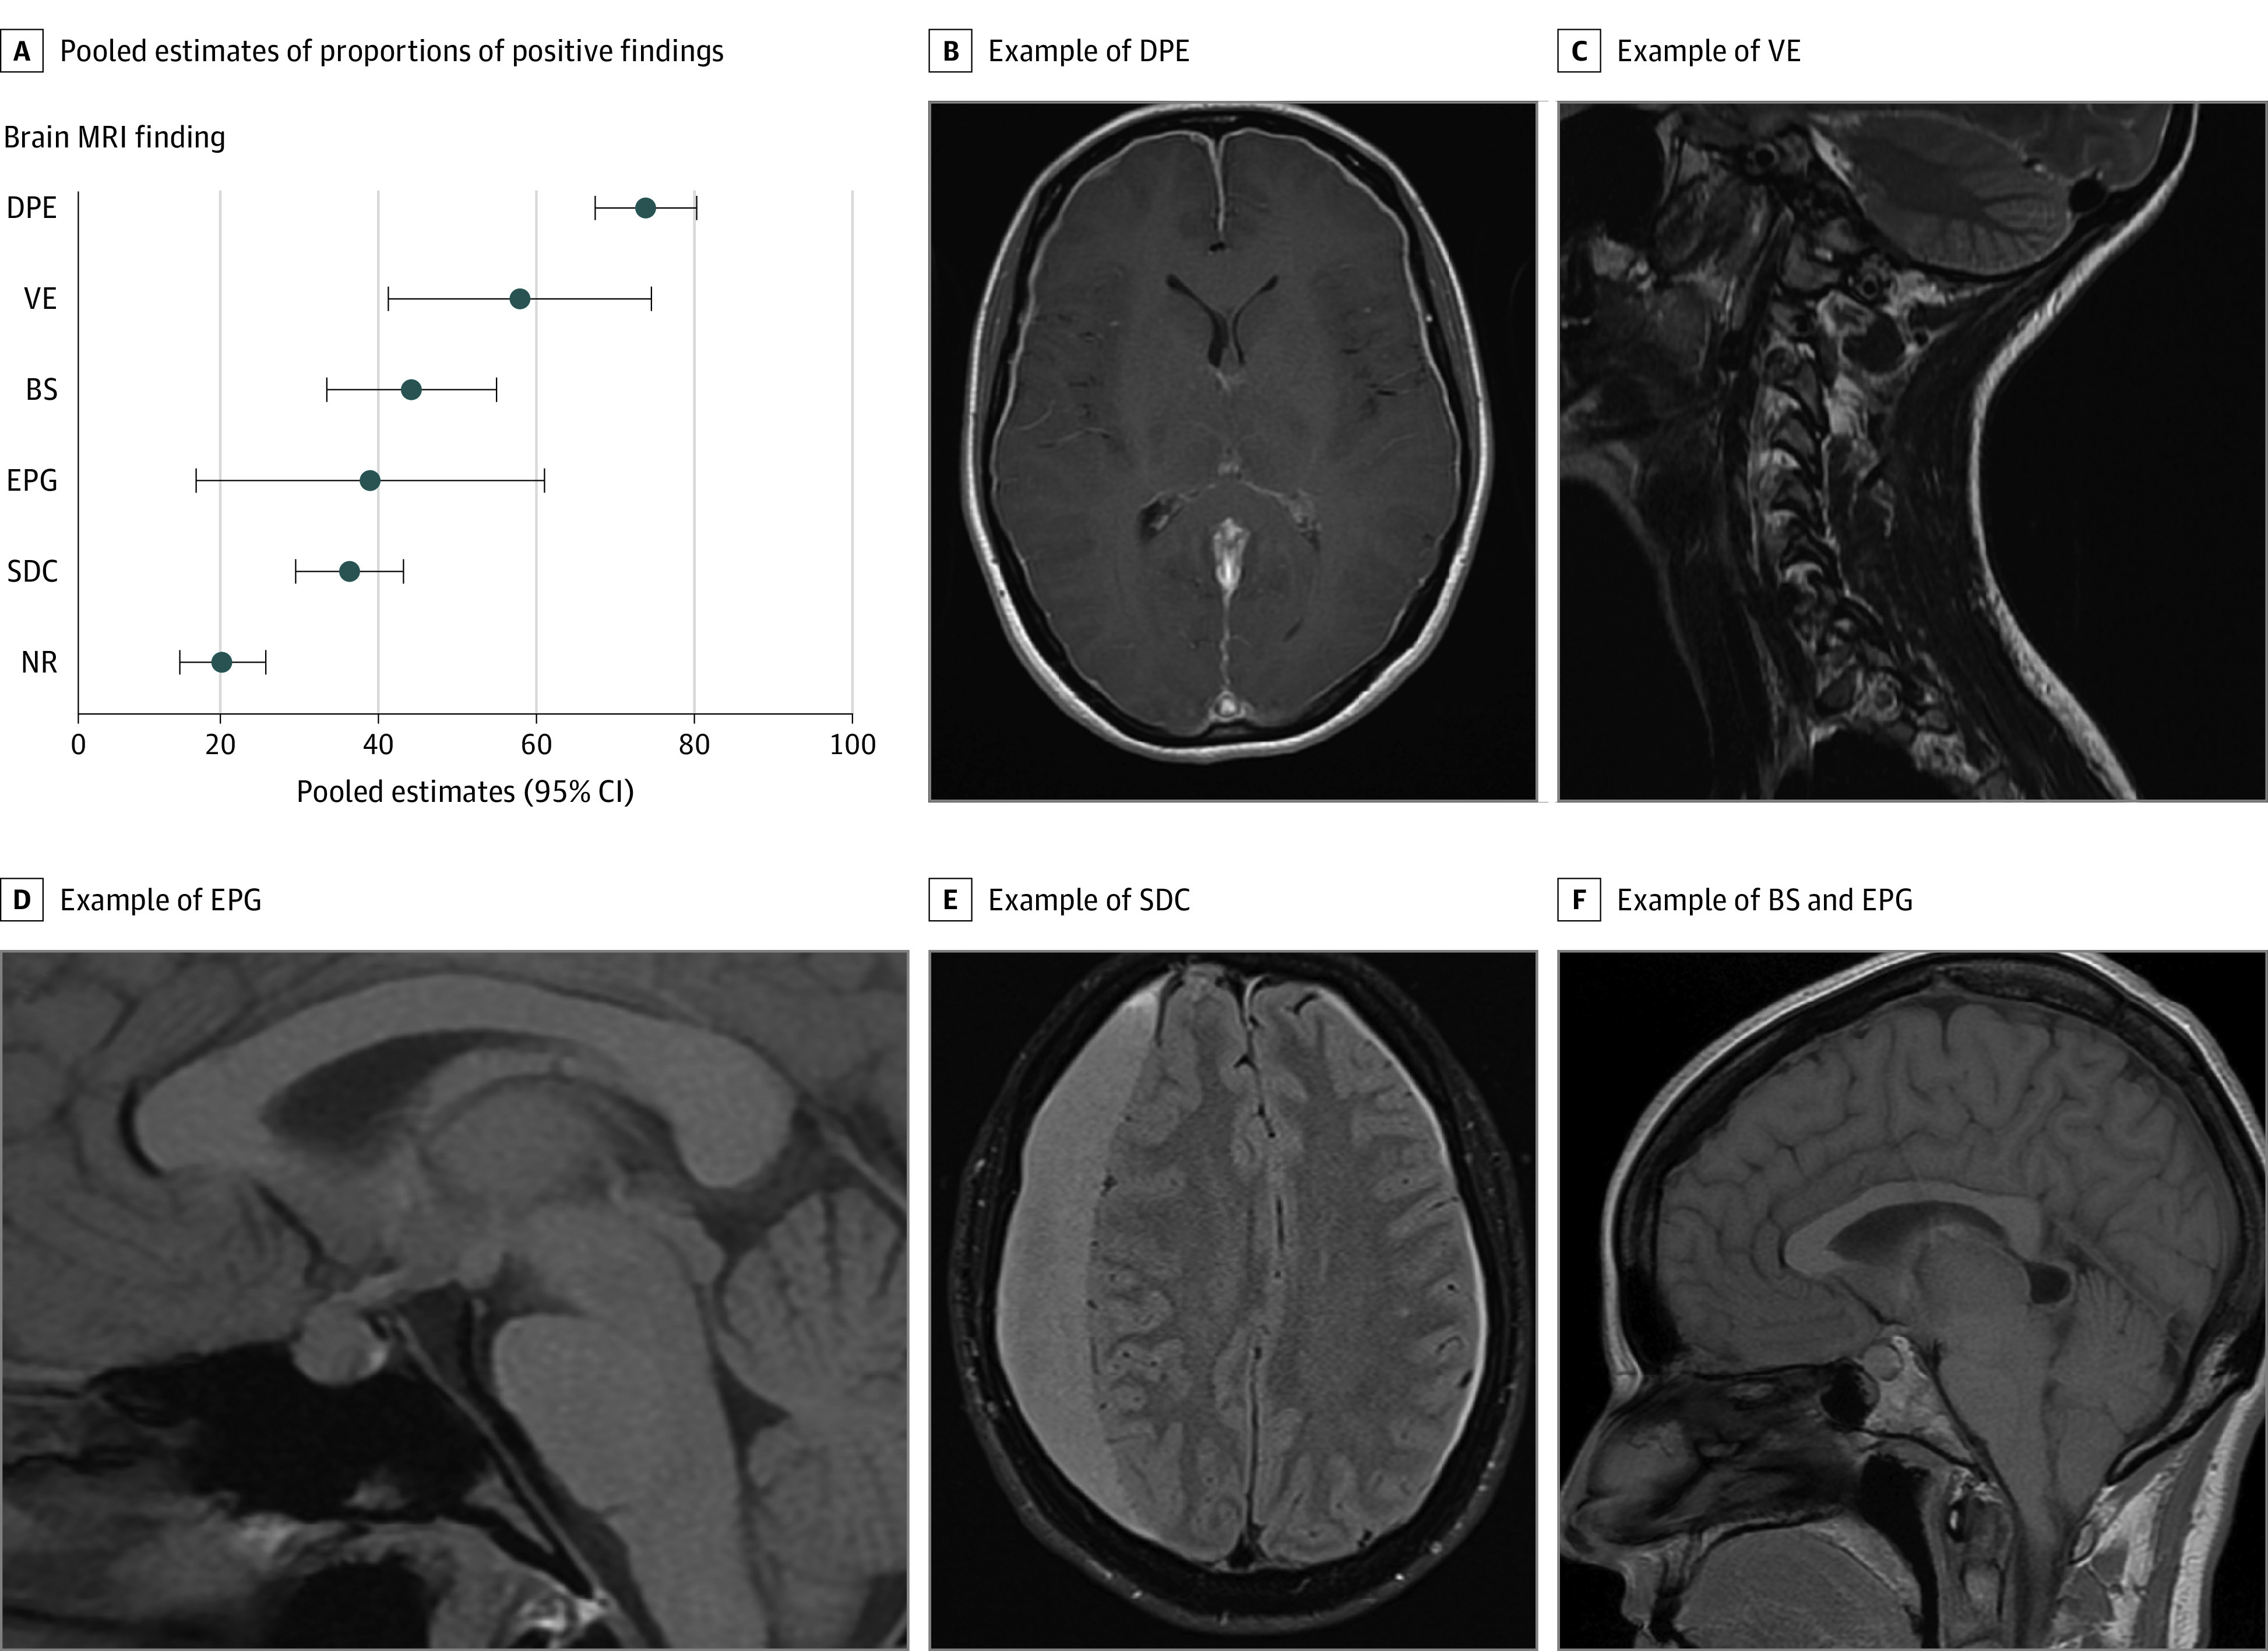
Brain Magnetic Resonance Imaging (MRI) Findings of Spontaneous Intracranial Hypotension A, Pooled estimates of proportions of positive findings in spontaneous intracranial hypotension. B, Example of diffuse pachymeningeal enhancement (DPE) in T1-weighted axial MRI sequence. C, Example of venous engorgement (VE, transverse sinus venous distension sign) in T2-weighted sagittal MRI sequence. D, Example of enlarged pituitary gland (EPG) in T1-weighted sagittal MRI sequence. E, Example of subdural collection (SDC) in T2-weighted axial MRI sequence. F, Example of brain sagging (BS) and enlarged pituitary gland (EPG) in T1-weighted sagittal MRI sequence. NR indicates normal.